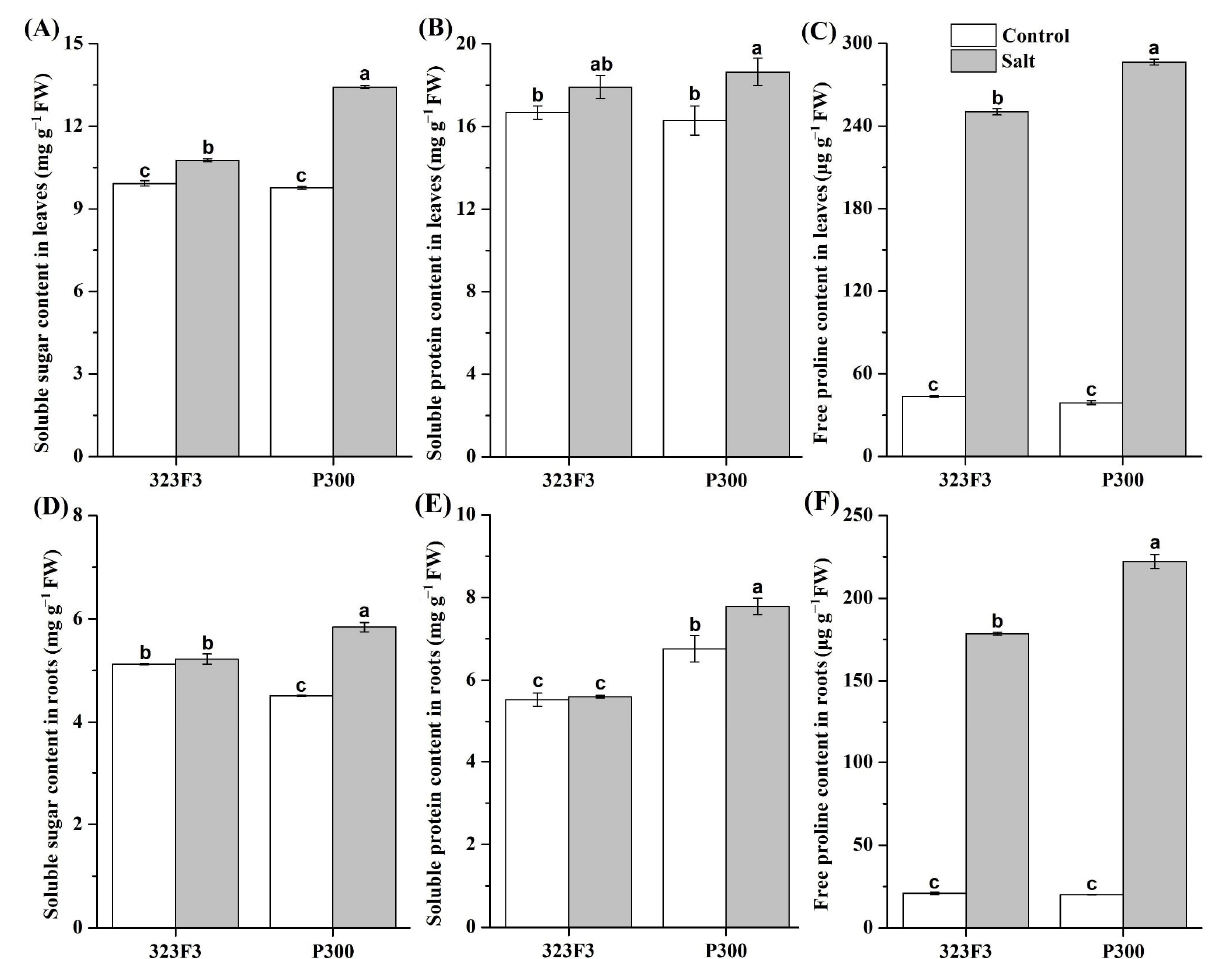
Figure 4. Accumulation of soluble sugar, soluble protein, and proline in the leaves ( A – C ) and roots ( D – F ) of 323F3 and P300. Each bar represents three biological replicates ± SD. Different small letters represent significant differences at p < 0.05 according to one ‐ way ANOVA.